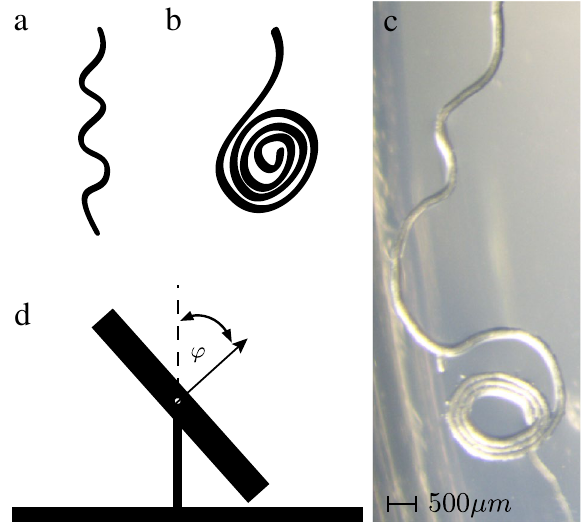
Figure 1. Root waving and coiling: ( a ) An illustration of root waving. ( b ) An illustration of root coiling. ( c ) An image showing an Arabidobsis root transitioning from a waving pattern to a coiling pattern. ( d ) An